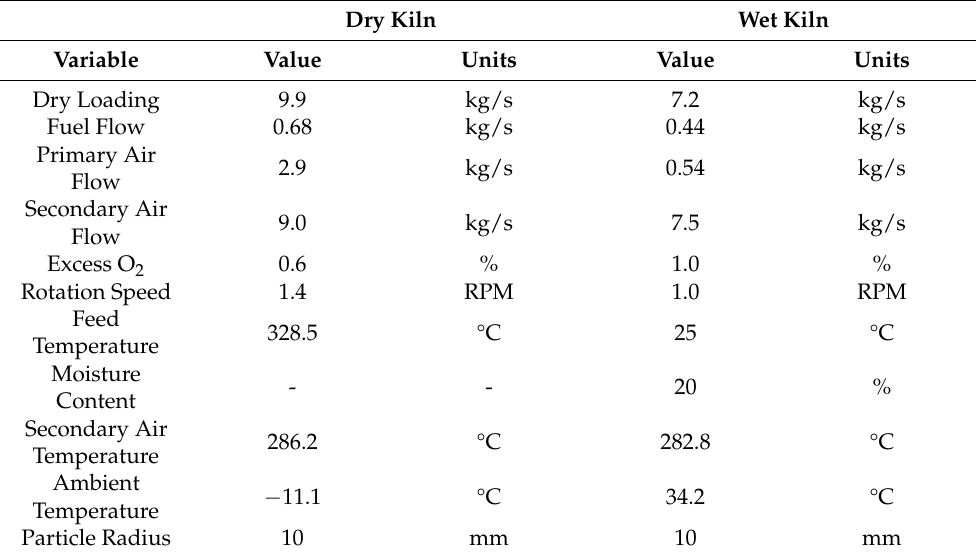
Table 2. Dry and wet kiln steady-state simulation